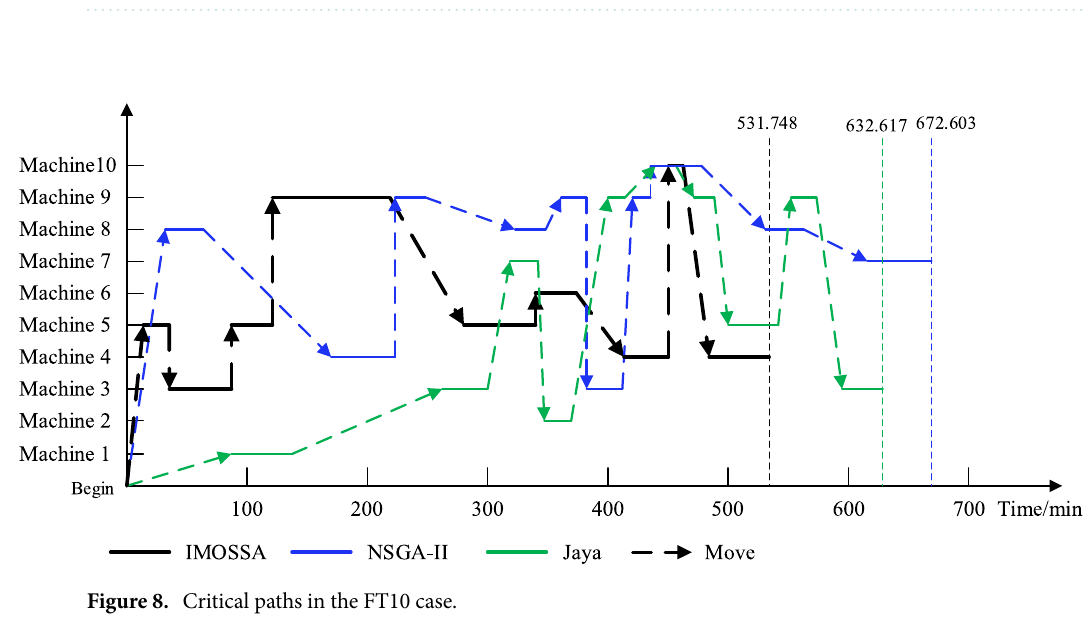
Figure 7. The Pareto fronts of LA06, FT10 and LA26.